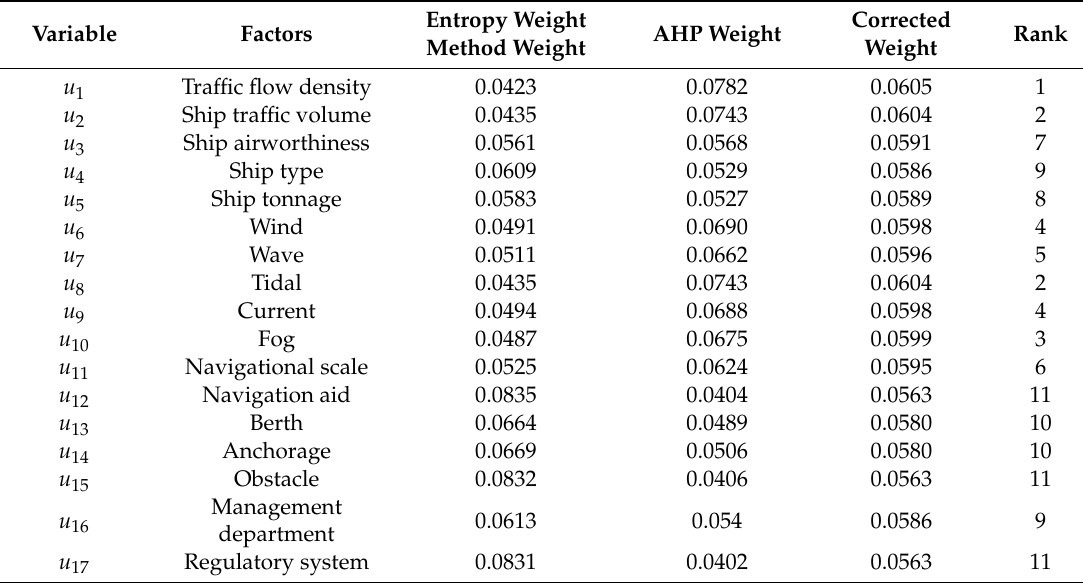
Table 4. Weighted ranking of vulnerability